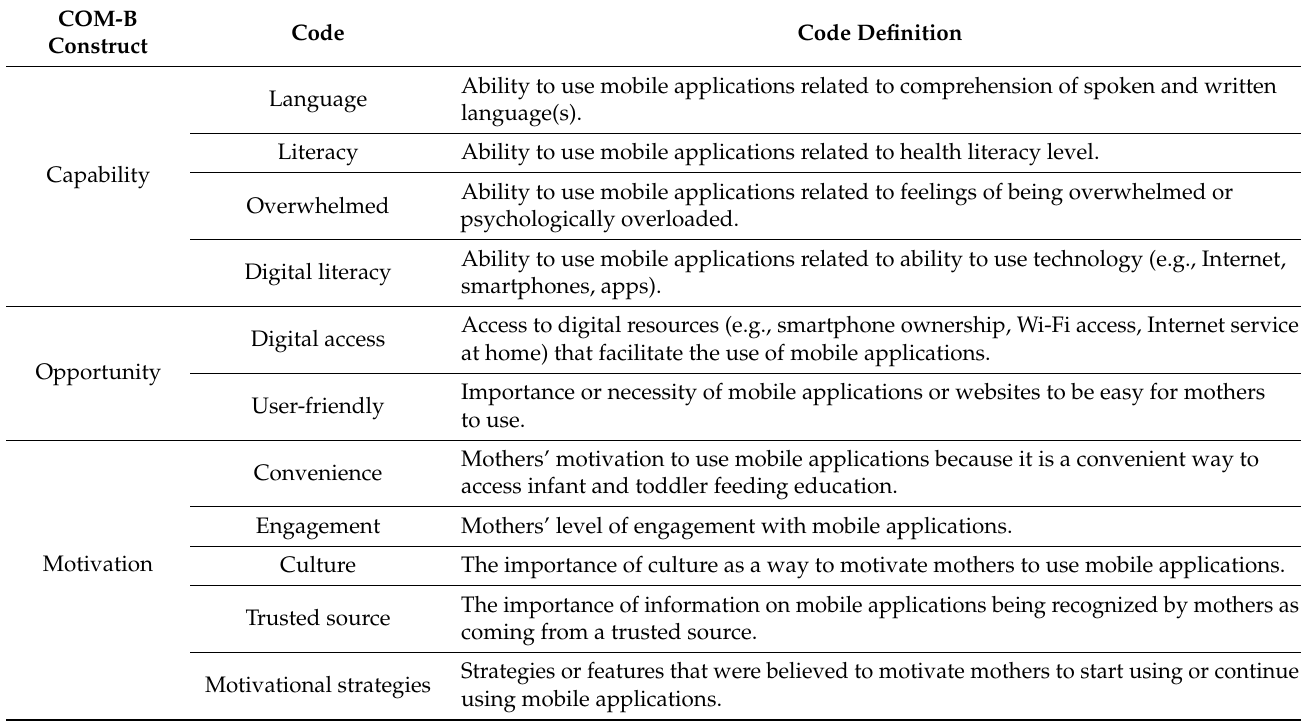
Table 2. Final codebook, with corresponding Capability Opportunity Motivation-Behavior (COM-B) construct, for analysis of interviews with stakeholder participants ( n =